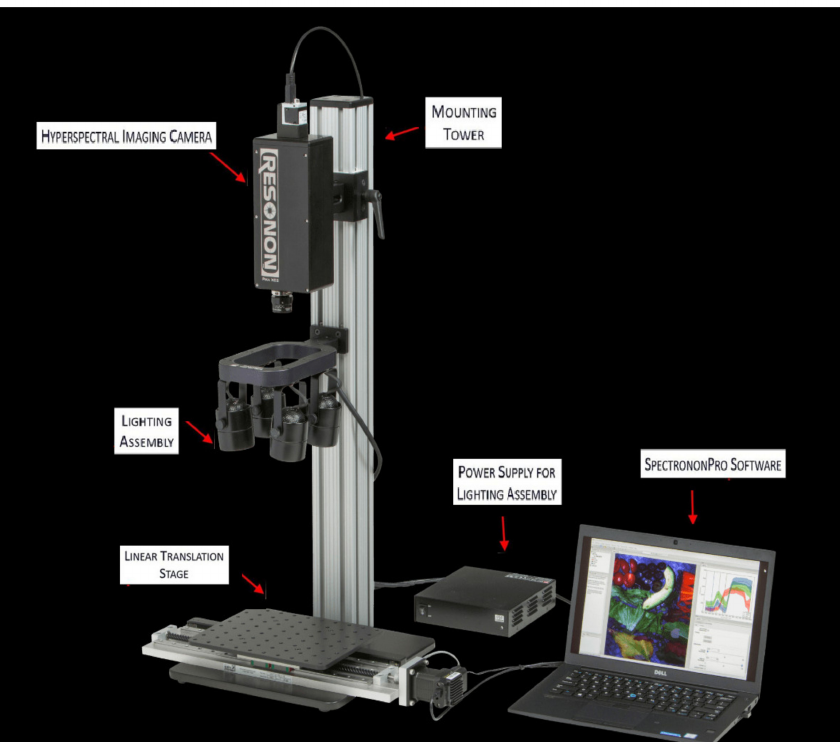
Figure 5. Proximal hyperspectral image acquisition device.